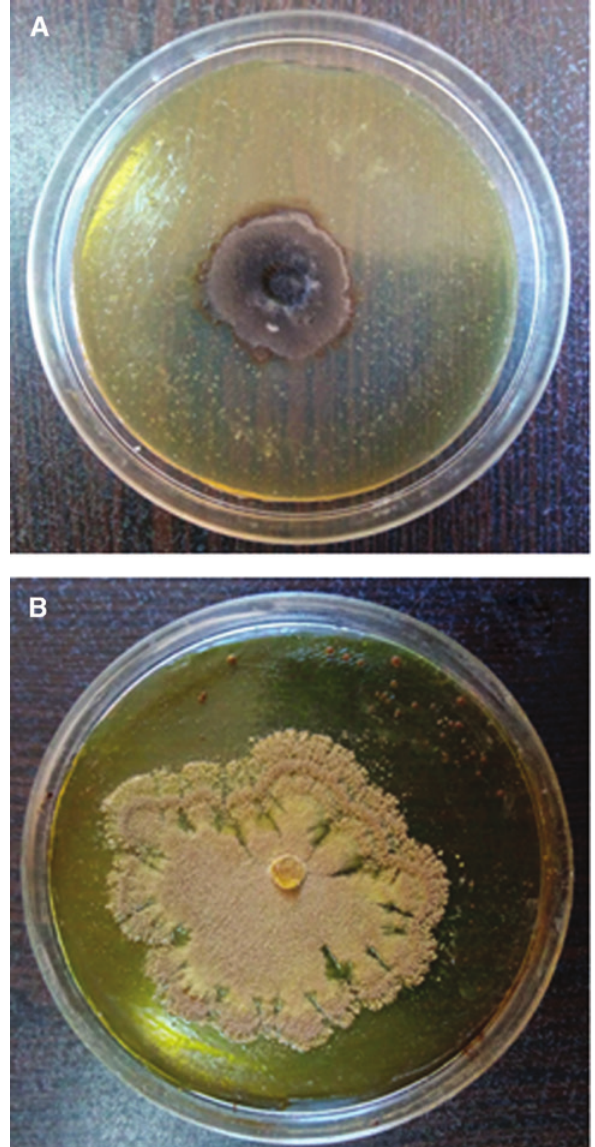
Figure 9: Mycelia growth inhibition of the synthesized AuNPs toward A. flavus (A) and A. terreus (B) after 10 days of incubation at 26 ° C ± 2 °